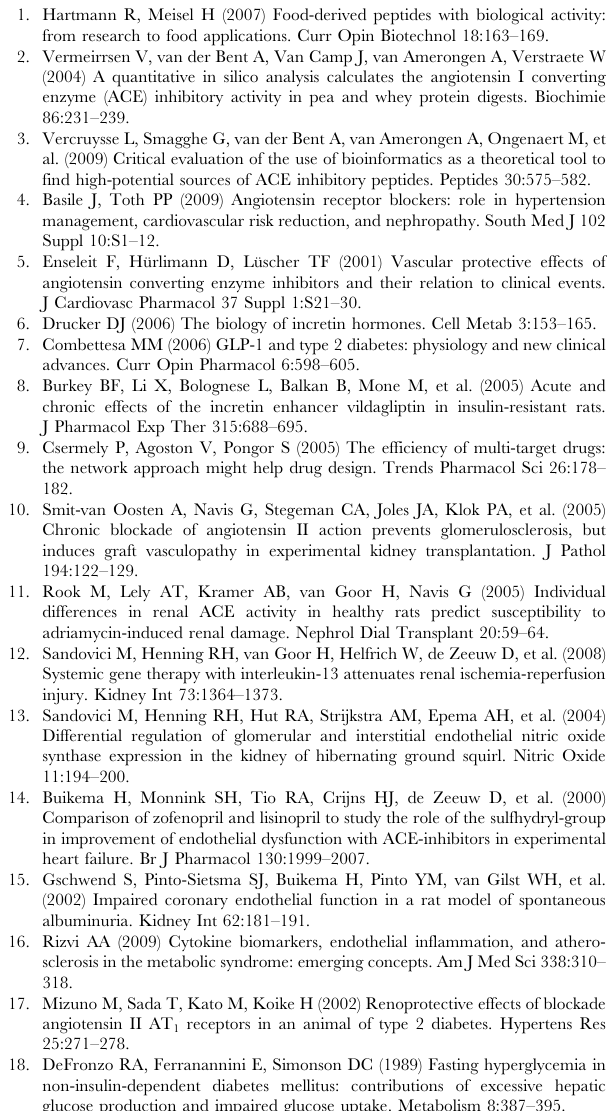
Figure S2 Acute effect of oral NWT-03 on plasma ACE activity and blood pressure in SHRs. ACE activity and blood pressure were determined 1.5 hours after administering